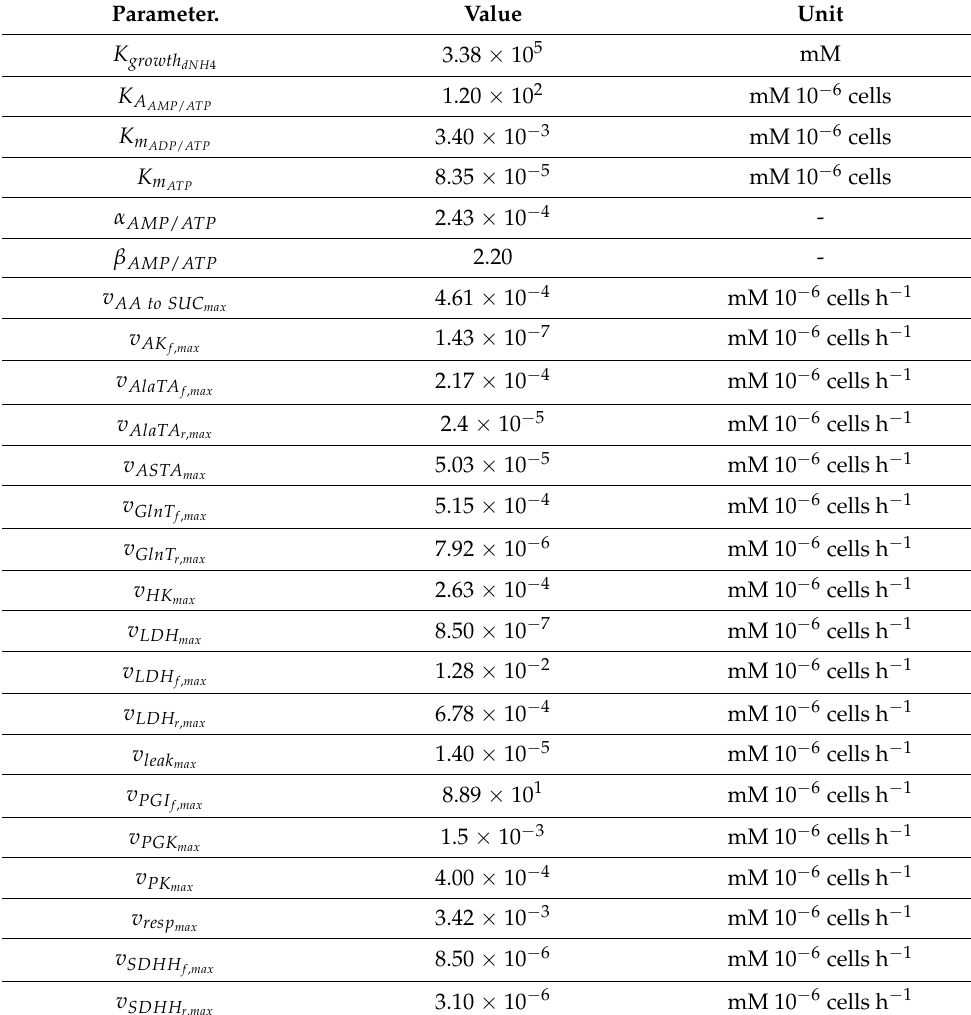
Table 1. Modified parameters and new parameter values.